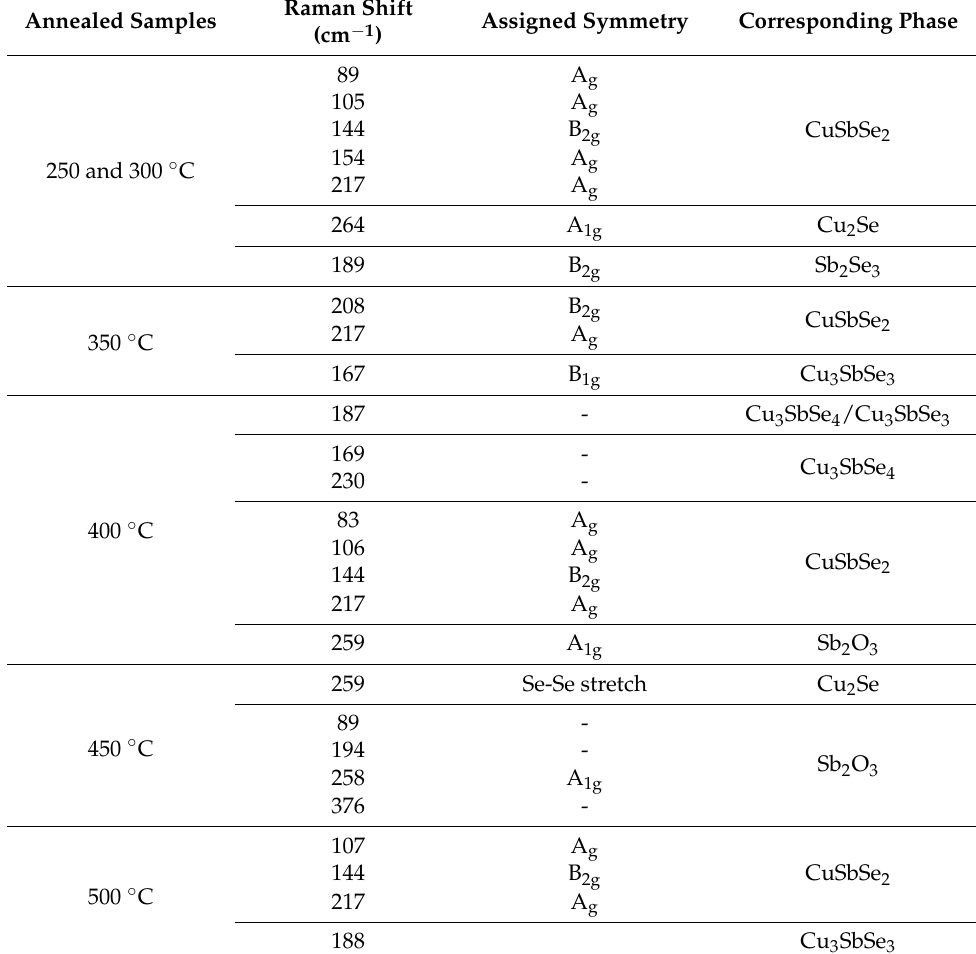
Table 2. Raman modes for CuSbSe 2 annealed at different temperature. Annealed